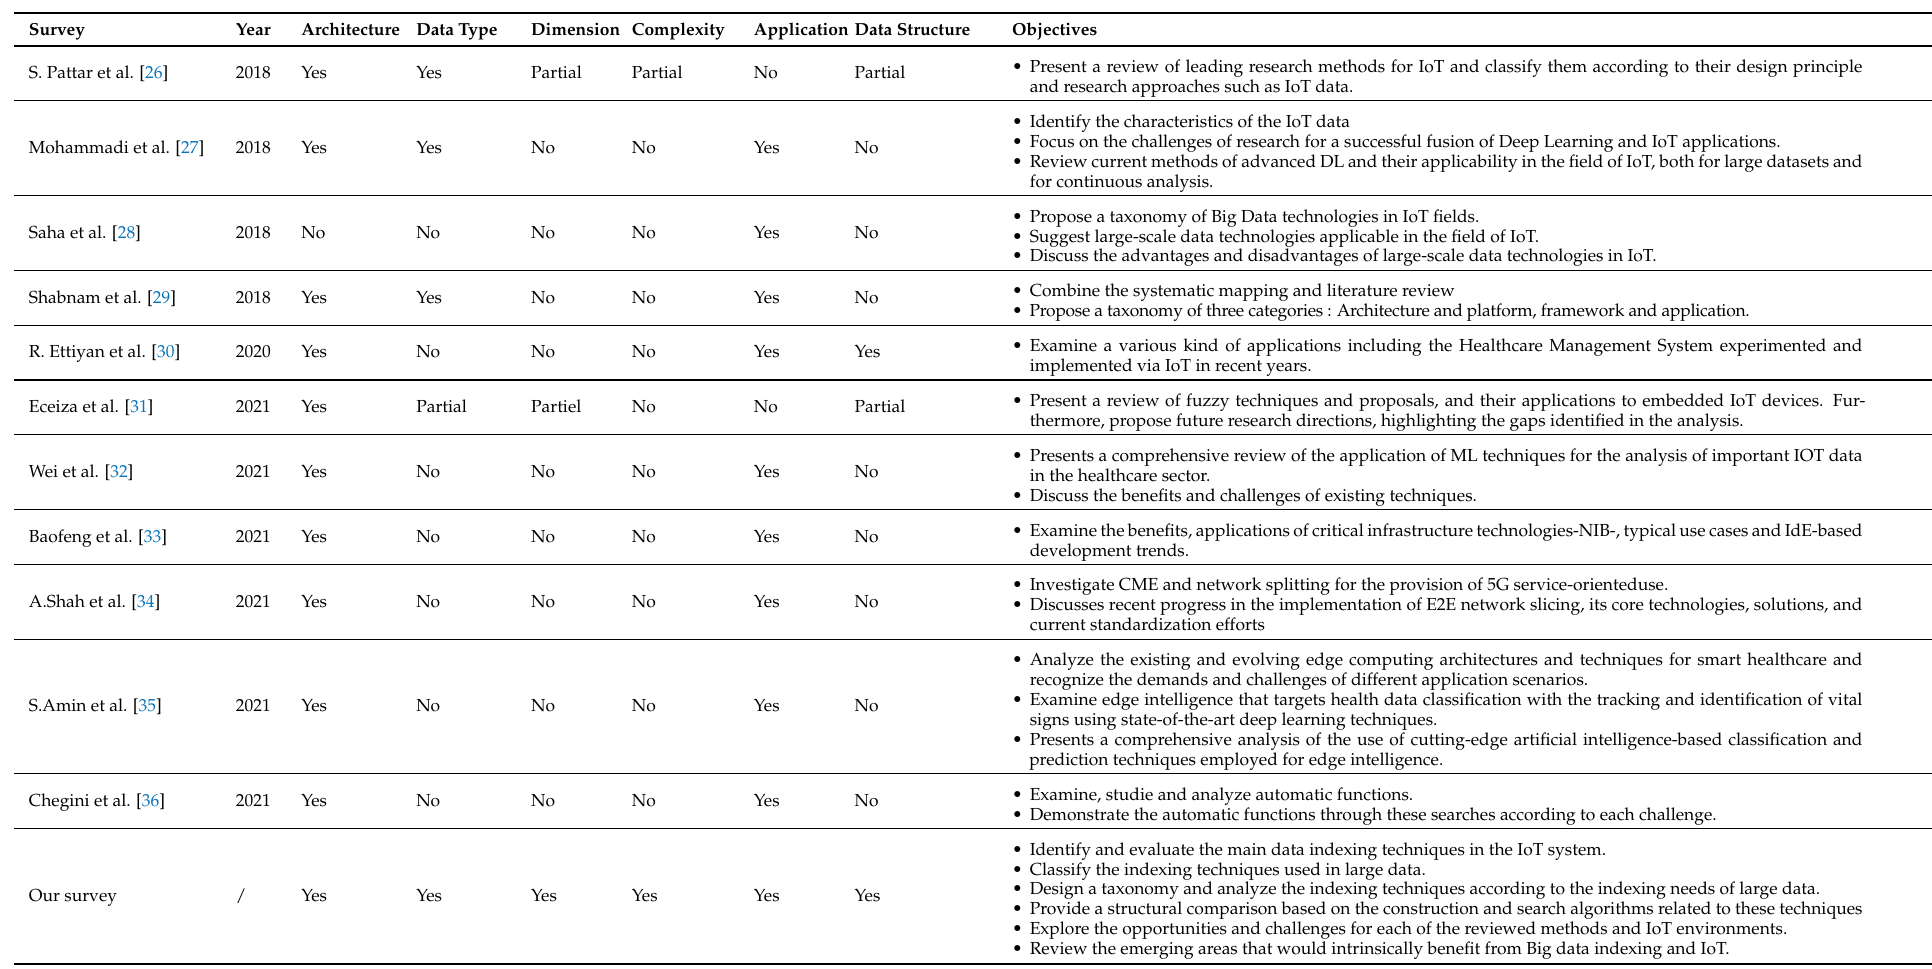
Table 1. Comparison of past